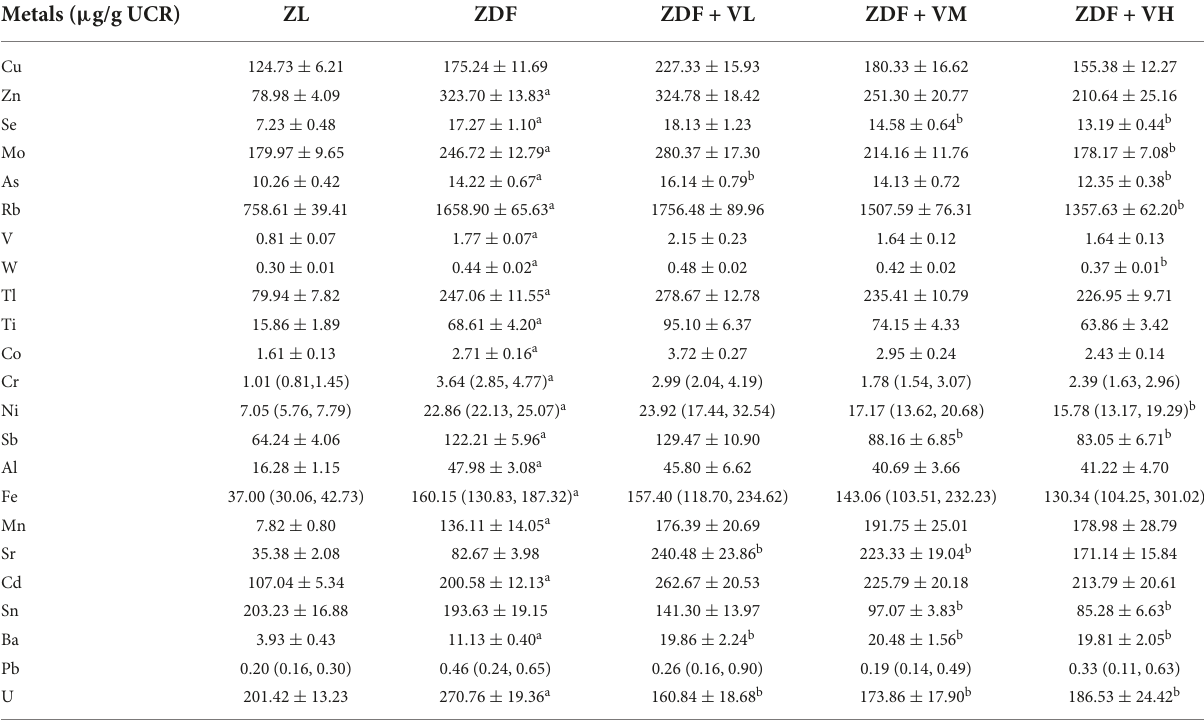
TABLE 3 Effects of 1,25(OH) 2 D 3 on urine metal concentration of Zucker rats in the fourth week of